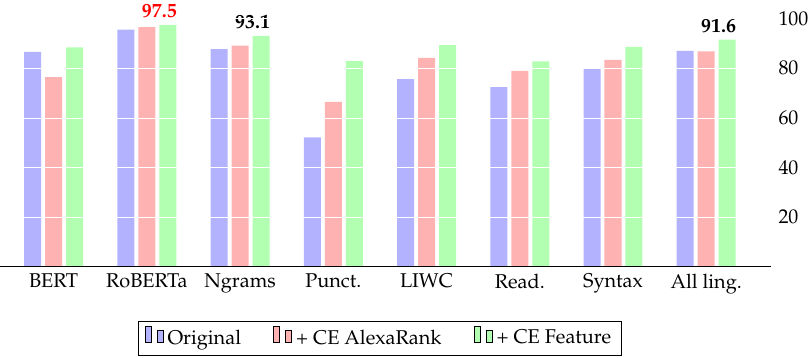
Figure 7. Results on the ReCOVert dataset ( F 1 score): adding our cross-lingual evidence (CE) improves various baseline systems and yields state-of-the-art result with RoBERTa model.